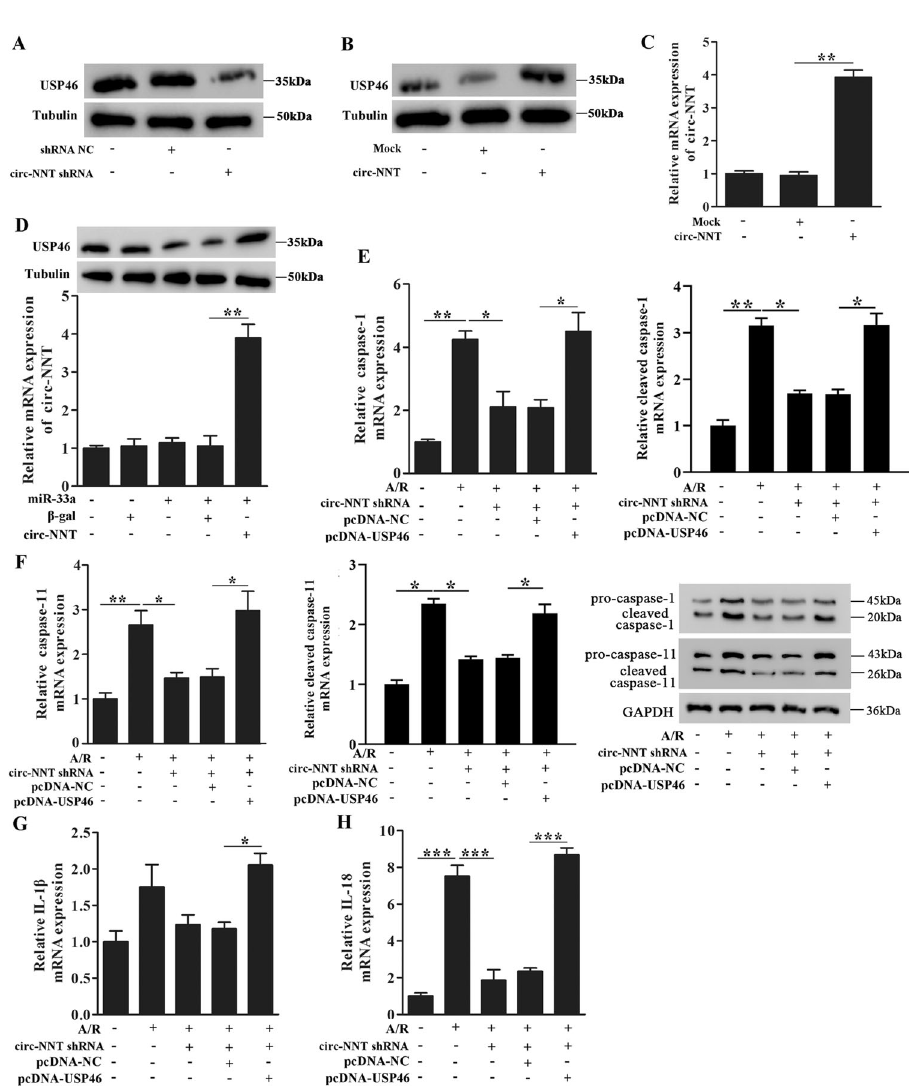
Fig. 8 Circ-NNT mediates A/R-stimulated cardiomyocytes pyroptosis through miR-33a-5p and USP46. A , B USP46 protein expression was detected by western blot in cardiomyocytes, which were transfected with shRNA NC/circ-NNT shRNA or Mock/circ-NNT. C The relative circ-NNT expression was determined by RT-PCR in cardiomyocytes, which were transfected with Mock/circ-NNT. D Cardiomyocytes were transfected with miR-33a-5p, β -gal, and circ-NNT, alone or in combination as indicated. USP46 and circ-NNT levels were determined by western blot analysis and RT-PCR, respectively. E – H Cardiomyocytes transfected with circ-NNT shRNA, pcDNA-USP46, and pcDNA-NC, alone or in combination as indicated were subjected to A/R (30 min/60 min). E , F The protein and mRNA expression of pro-caspase-1, cleaved caspase-1, pro-caspase-11, and cleaved caspase-11 were detected by western blot and RT-PCR, respectively. G , H The mRNA expression of IL-1 β ( G ) and IL-18 ( H ) were determined by RT-PCR. n = 3, * P < 0.05, ** P < 0.01, *** P < 0.001.